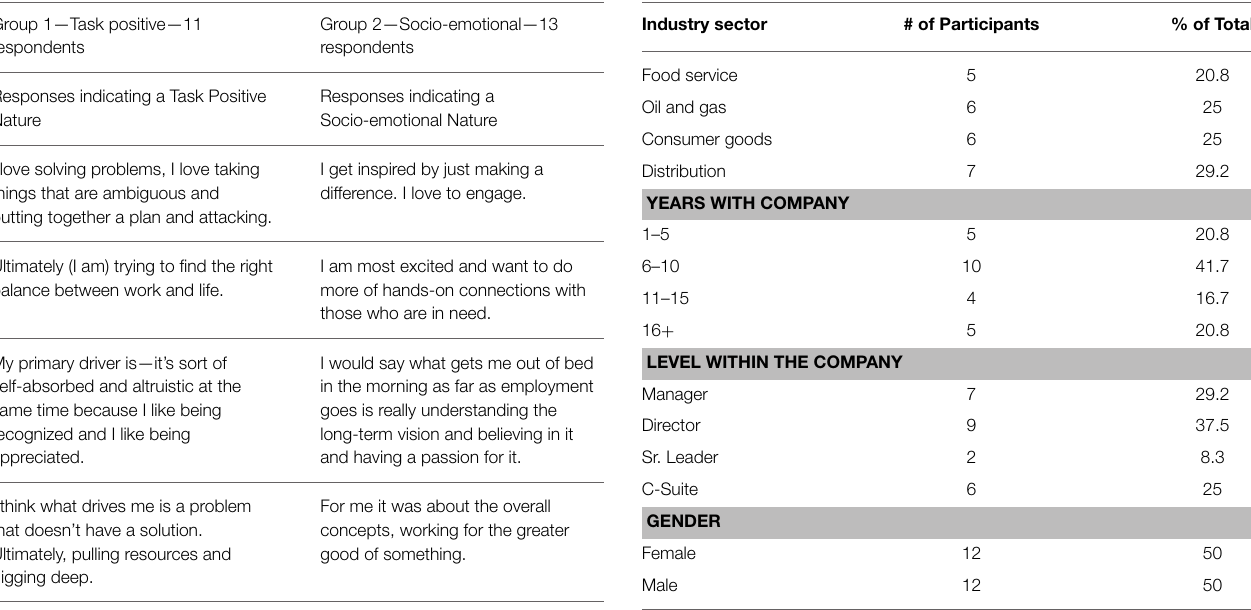
TABLE 2 | Descriptors applied to